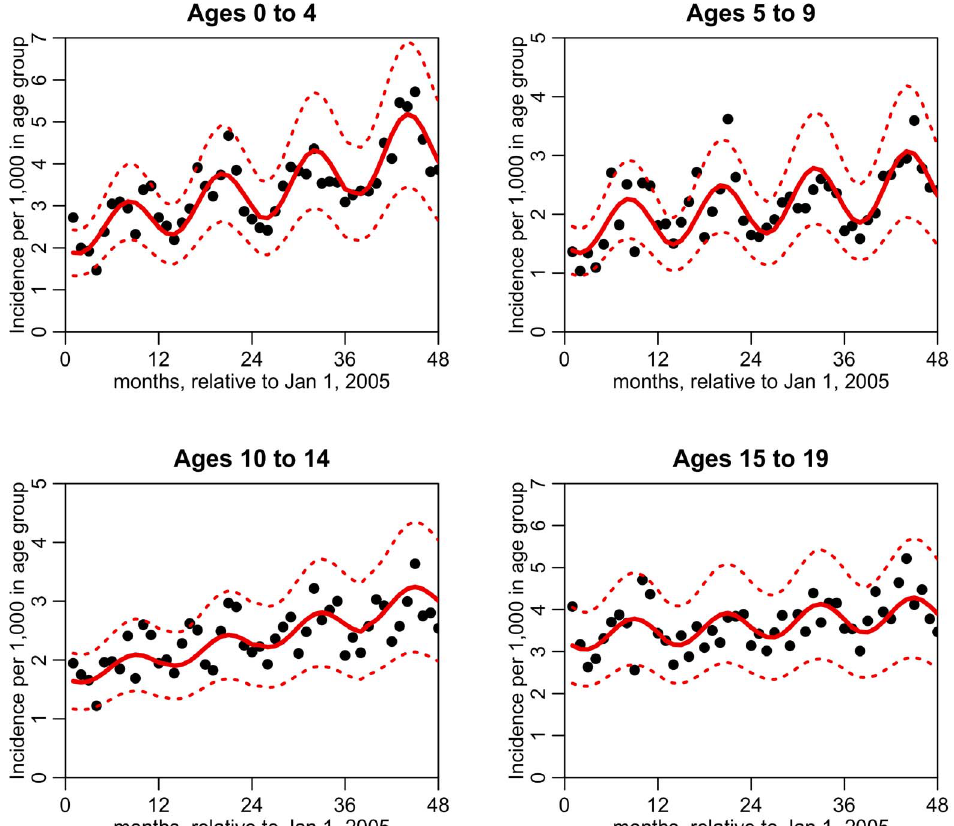
Figure 3. Time series of monthly SSTI incidence in four pediatric age groups (points), and the best fit of linear trend plus seasonality with period 12 months (red line). The dotted red lines indicate the 95% CI on the fit prediction.